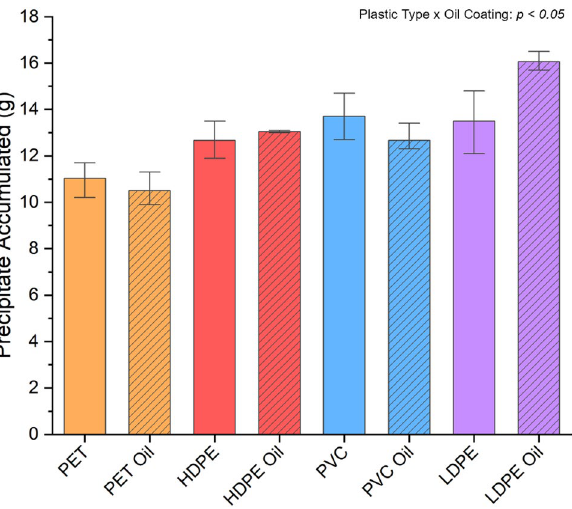
Figure 2. Mass of calcium carbonate attached to 121 g of each plastic type. The bar heights represent the mean, and the error bars indicate one standard